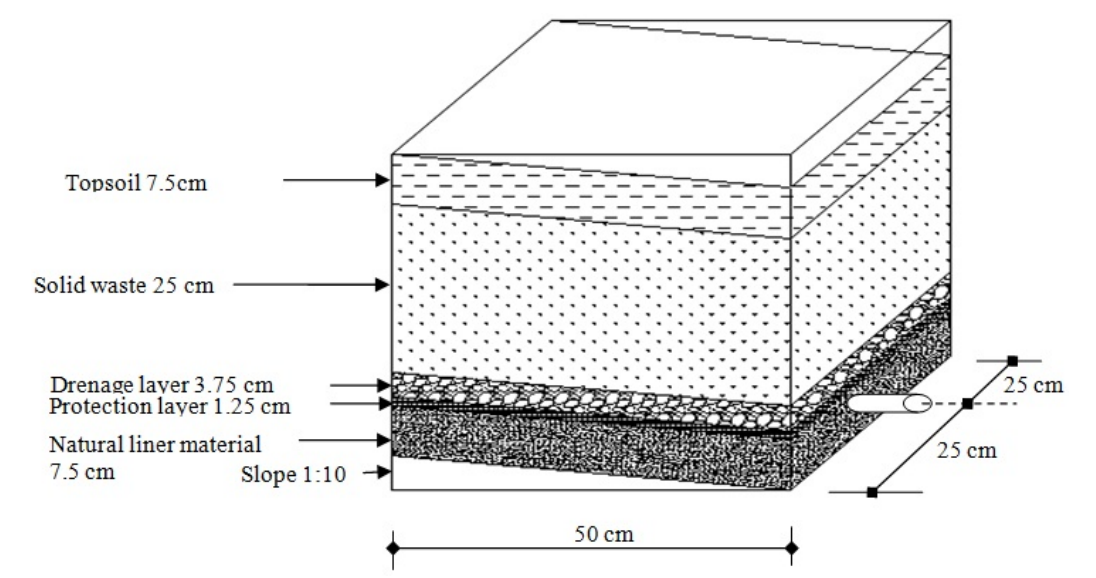
Figure 1. Schematic of the test apparatus.